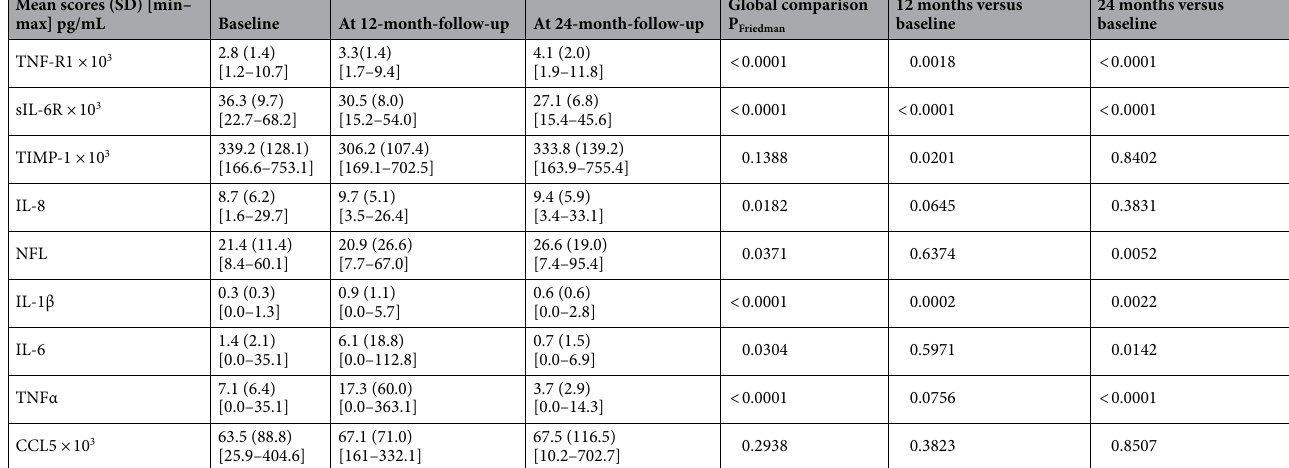
Table 2. Inflammatory markers levels at baseline, and at 12 and 24 months from the baseline. SD, Standard deviation; TNFR-1, tumor necrosis factor receptor 1; sIL-6R, soluble interleukin 6 receptor; TIMP-1, tissue inhibitor of metalloproteinases 1; IL-8, interleukin 8; NFL, neurofilament light protein; IL-1β, interleukin 1β; IL-6, interleukin 6; TNFα, tumor necrosis factor α; CCL5, chemokine ligand